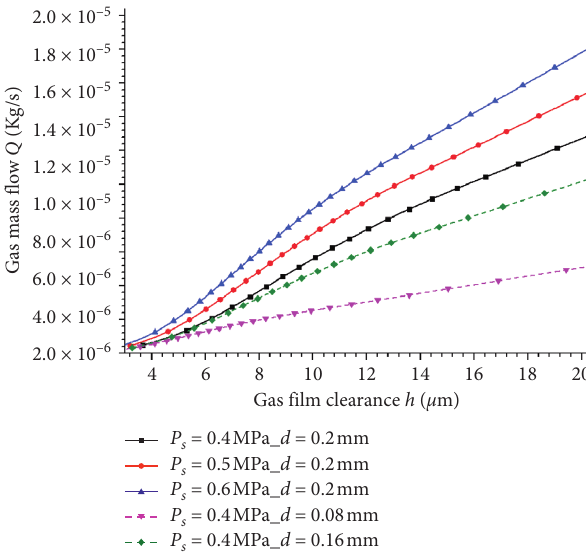
Figure 6: Change curve of gas mass flow under different influence parameters under different influence